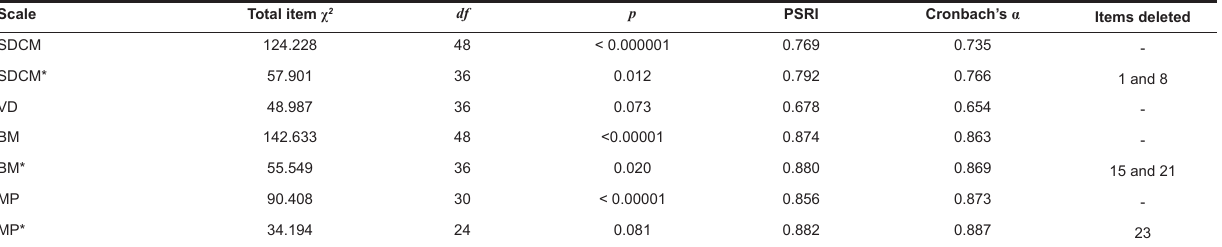
TABLE 4 Total Chi-Square fit statistics, person separation indices and Cronbach’s alpha for the self-directed career management, values driven, boundaryless mindset and mobility preferencesubscales